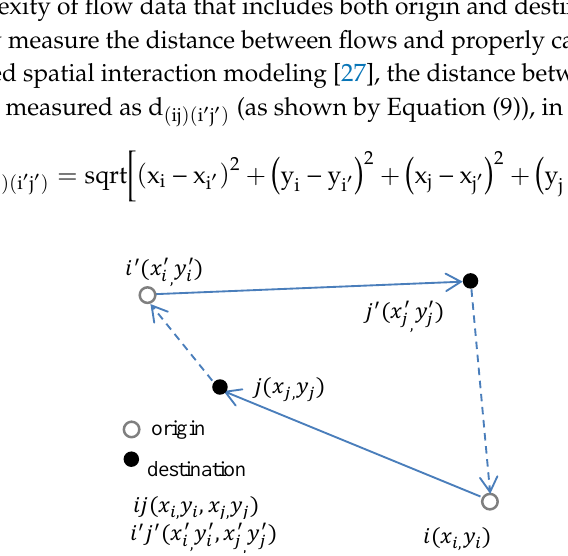
(cid:48) (cid:48) j